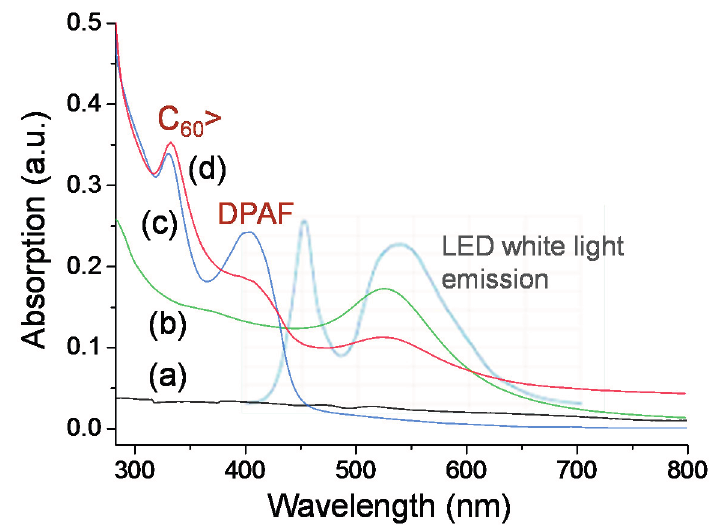
Figure 5. UV-vis absorption of ( a ) γ -FeO x NPs stabilized by n -C 10 H 21 NH 2 ; ( b ) γ -FeO x @AuNP stabilized by n -C 8 H 17 SH; ( c ) C 60 (>DPAF-C 9 ) 1 in CHCl 3 ; and ( d ) 3 – 1 in CHCl 3 ‒ THF (1:5) with their absorption correlation to emission bands ( light blue ) of white LED light